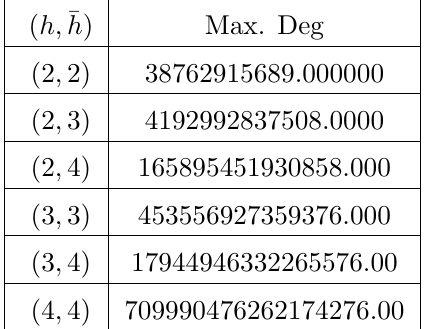
Table 10. The maximum value of degeneracies for low-lying states in a putative CFT with c = 24. The maximum number of derivatives is set to N max = 55, while the spin was truncated at j max = 40.